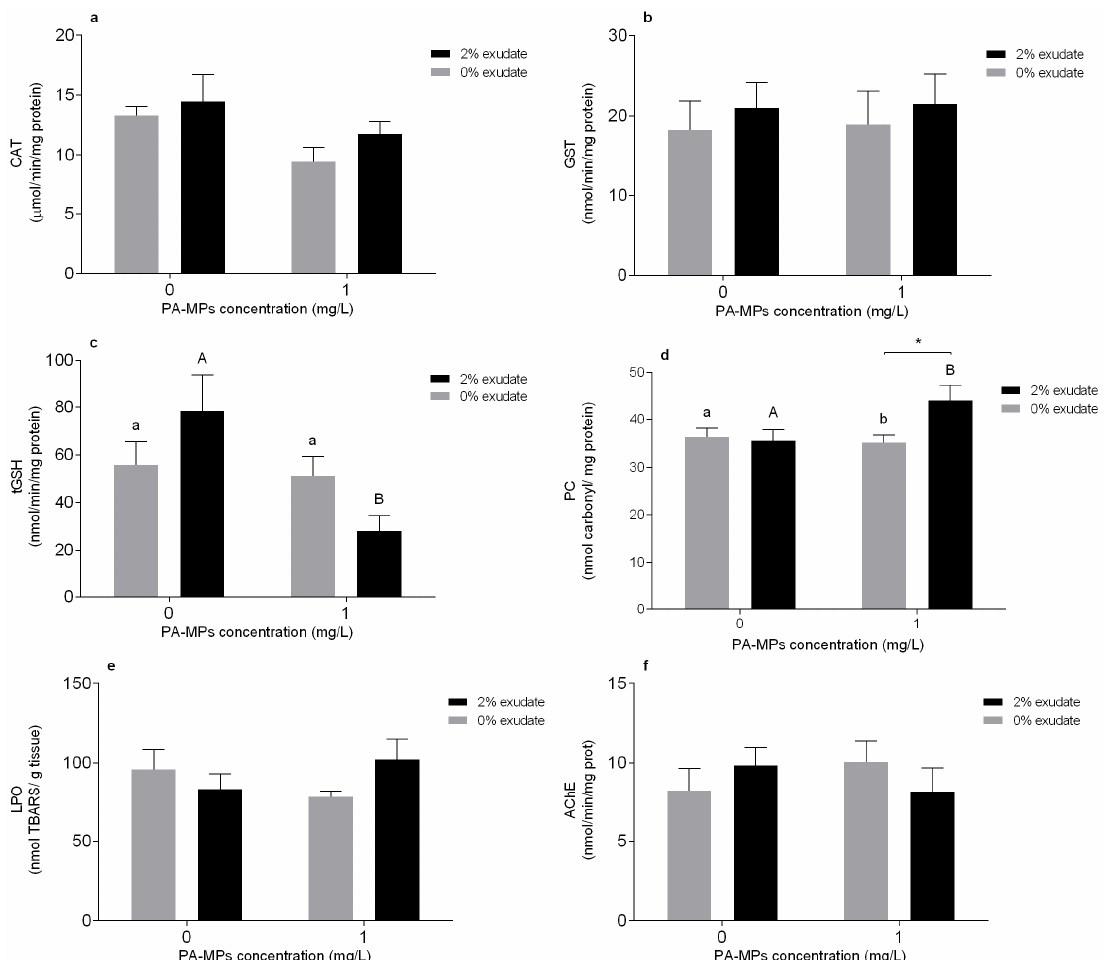
Figure 1. Oxidative stress-related biomarkers of Mytilus galloprovincialis gills after 96 h of exposure to A. armata exudate (0% and 2%) at different polyamide microplastic (PA-MPs) concentrations (0 and 1 mg/L). ( a ) Catalase activity (CAT), ( b ) glutathione- S -transferase activity (GST), ( c ) total glutathione contents (tGSH), ( d ) protein carbonylation levels (PC), ( e ) lipid peroxidation (LPO), and ( f ) acetylcholinesterase activity (AChE). All values are presented as mean ± SEM. * denotes a significant difference between the 0% and 2% A. armata exudate in the same PA-MPs concentration. The upper-case letters indicate differences in the 0% exudate treatments and the different lower-case letters represent differences in the 2% exudate treatments at the different PA-MPs concentrations. In the muscle, LPO (Figure 3a) and PC (Figure 3b) did not undergo significant alter- ations ( p > 0.05) when exposed to exudate, PA-MPs, or their interaction (Table S3). On the other hand, the AChE activity was significantly affected in mussels exposed to A. armata exudate ( p < 0.05) but was not influenced ( p > 0.05) by the presence of PA-MPs or by the interaction between factors (Table S3). Despite that, no statistical differences among treatments were observed (Figure